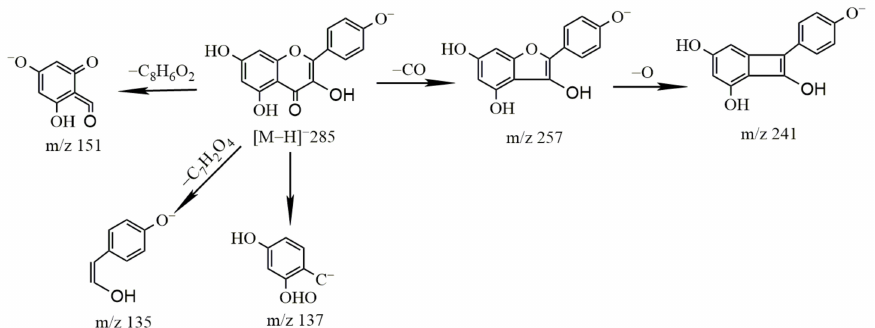
Figure 7. The cleavage pathway of